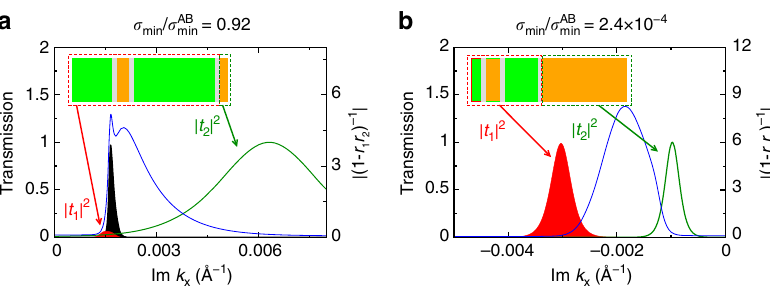
Fig. 4 Multiple scattering at the boundary between bilayer terraces. Two partial con fi gurations with similar terrace disorder L rms ≈ 0.4 exhibit two very different transport states: conducting a and insulating b . Green/orange shading indicates AB/AC stacked terraces, with grey denoting the partial dislocations (not drawn to scale). By division of the sample into two sub-systems, as indicated by the dashed boxes , the transport problem can be expressed in terms of the transmission functions of the sub-systems t 1/2 and multiple scattering between the sub-systems (1 − r 1 r 2 ) − 1 = 1 + r 1 r 2 + ( r 1 r 2 ) 2 + … , with | r 1 | 2 ( | r 2 | 2 ) the probability of a left ( right ) moving wave re fl ecting from system 1 (2). The origin of the conducting state is then seen to lie in the coincidence of a sub-system transmission maximum with the maximum of the multiple scattering term — clearly present in system a , but not in system b — or, in other words, in a resonance between bilayer terraces